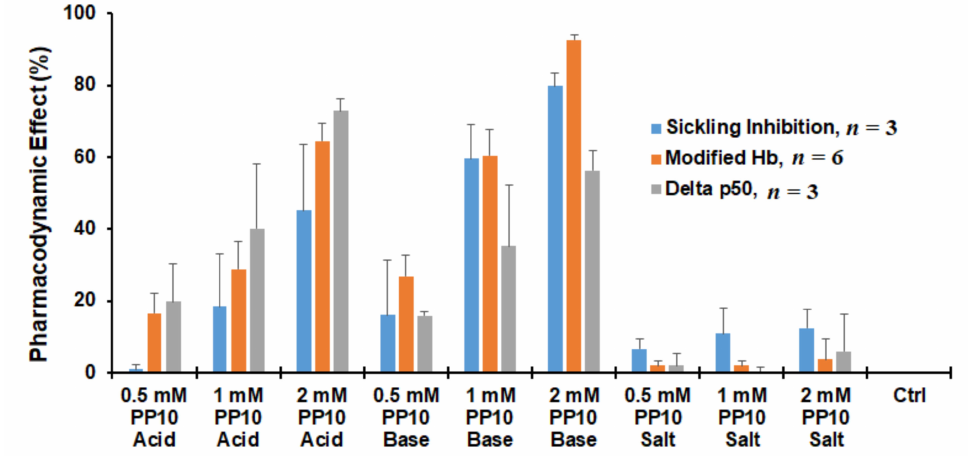
Figure 5. Dose-dependent pharmacodynamic activity (RBC sickling inhibition, Hb adduct formation, and P 50 shift) of PP10, PP10-acid, and PP10-NaSalt in sickle blood (HCT